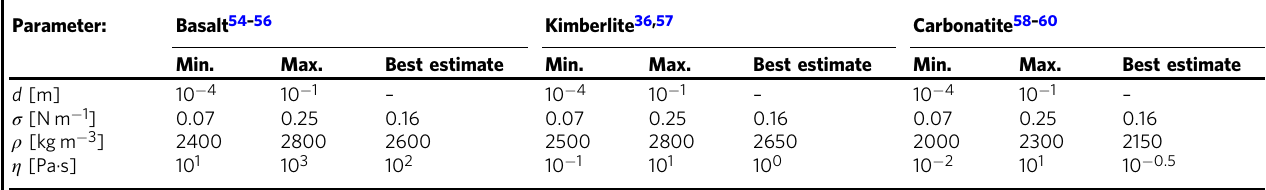
Table 1 Physical property data for the melts of basaltic, kimberlitic and carbonatitic composition used in this study Parameter: